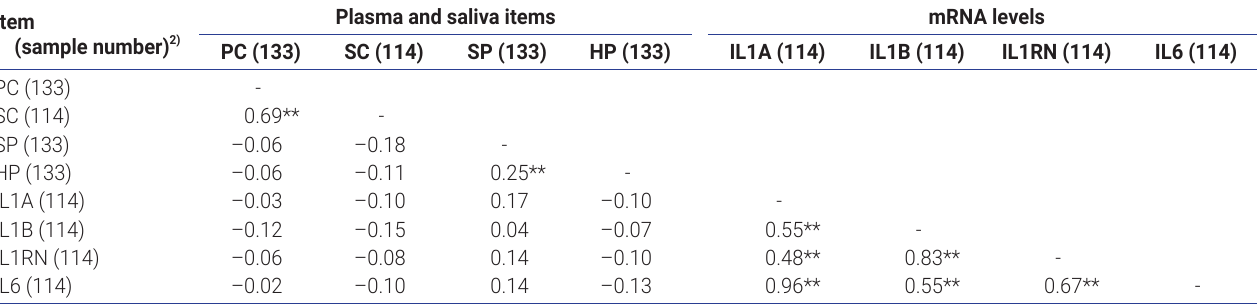
Table 3. Pearson correlation coefficients among plasma and saliva parameters and blood leukocyte cytokine mRNA levels in Korean cattle calves 1)